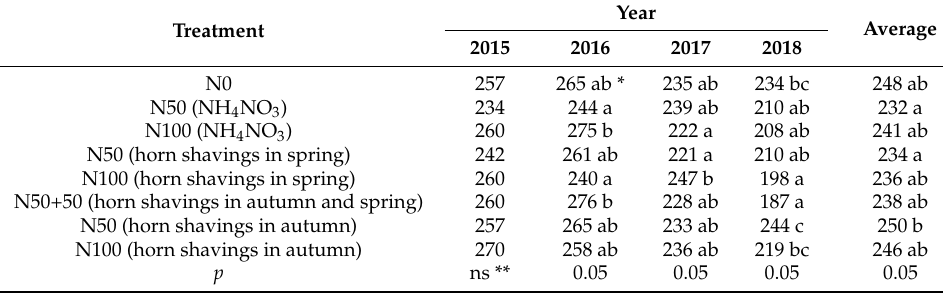
Table 6. Fertiliser effect on Ligol apple average fruit weight